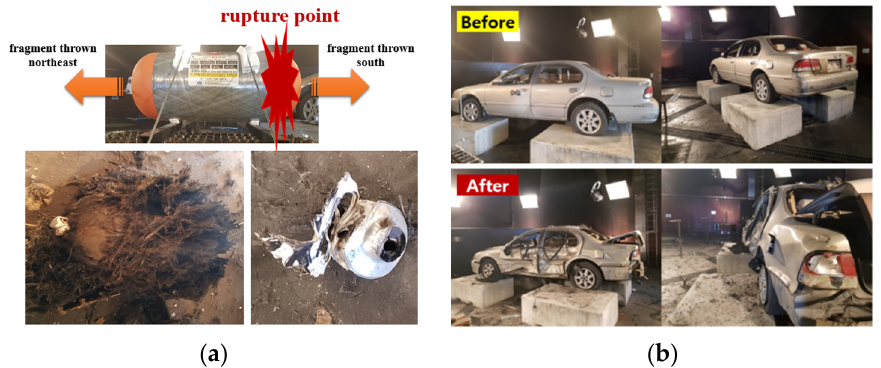
Figure 6. Observed damage to the hydrogen tank and vehicle: ( a ) exploded hydrogen tank; ( b ) vehicle damage.